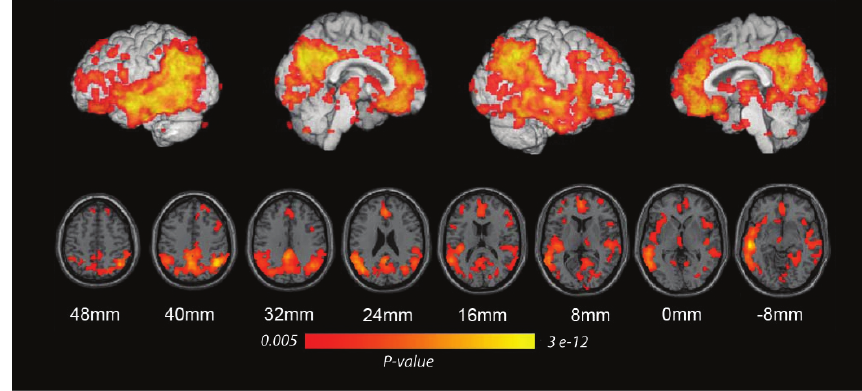
Fig. 1. Statistical pattern of FDG PET change over 12 months in AD sample. Statistical region of interest representing 12 month FDG PET signal change in a training set of 27 subjects from the ADNI dataset. This pattern of AD-like change can be used as an outcome measure to identify effects of putative treatments for AD in randomized clinical trials.